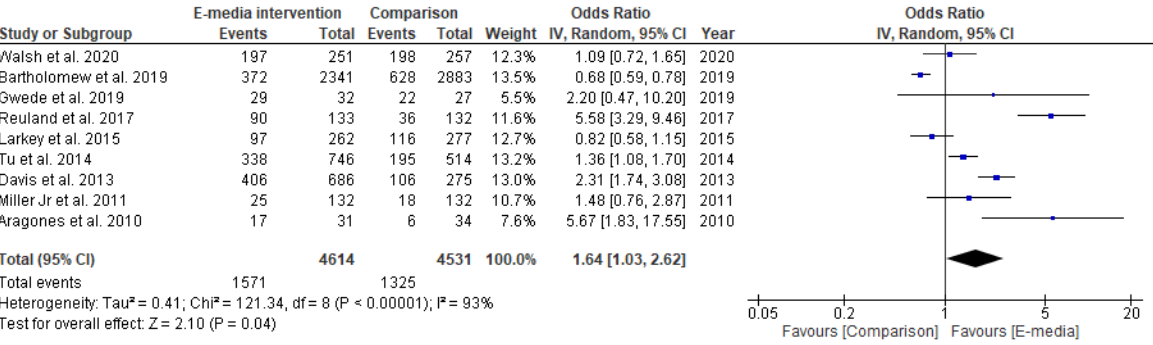
Figure 4. Random-effects forest plot for studies eligible for meta-analysis ( n = 9). Box size represents study weighting. Diamond represents overall effect size and 95% CI.